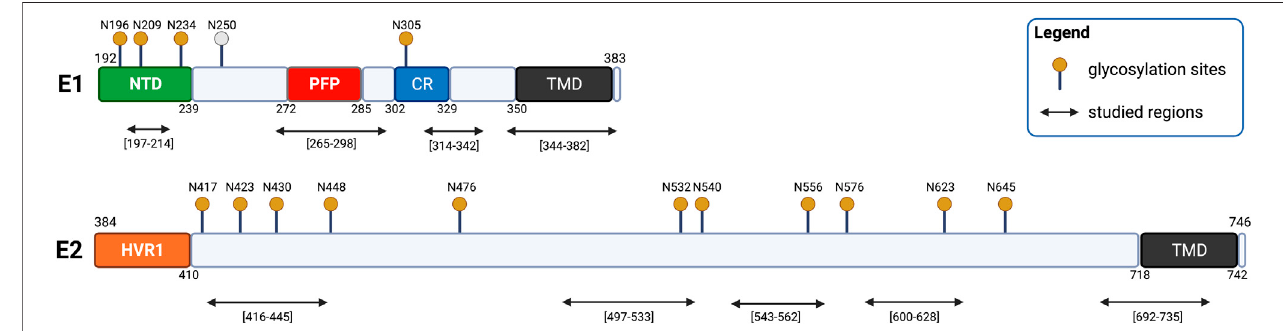
FIGURE6| SchematicrepresentationofHCVglycoproteinsE1andE2.E1iscomposedofan N -terminaldomain(NTD,yellow),aputativefusionpeptide(PFP,red), a conserved region (CR, blue), and a transmembrane domain (TMD, black). E2 is composed of two hypervariable regions (HVR1 and HVR2, orange) and a transmembrane region (TMD, black). The glycosylation site N250 is speci fi c to genotype 1b/6.